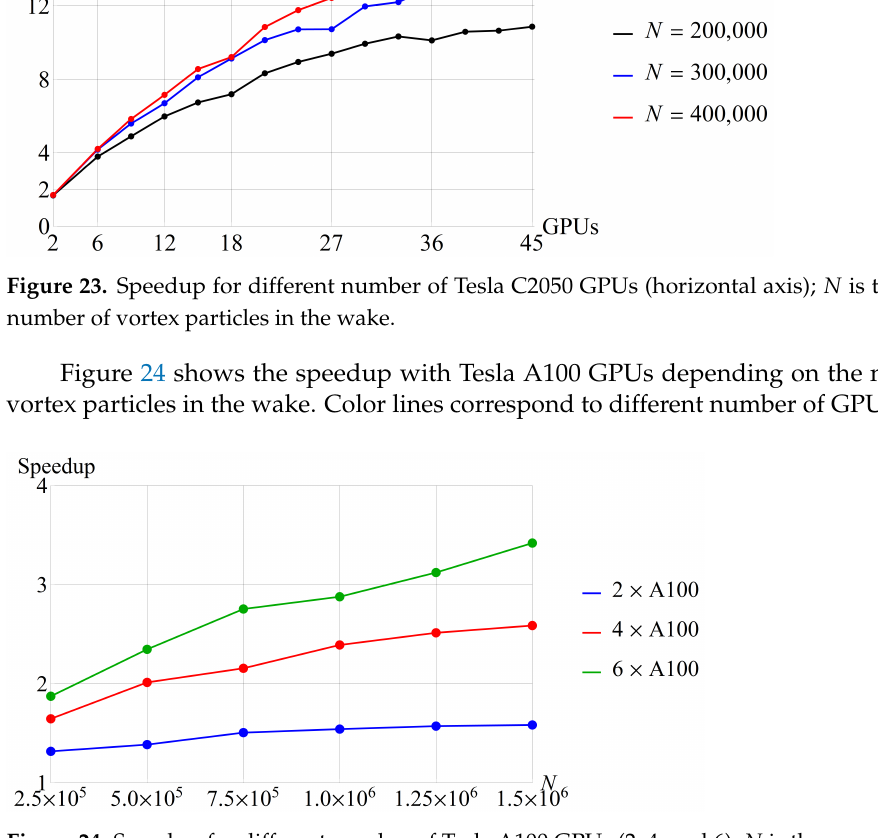
Figure 24. Speedup for different number of Tesla A100 GPUs (2, 4, and 6); N is the average number of vortex particles in the wake (horizontal